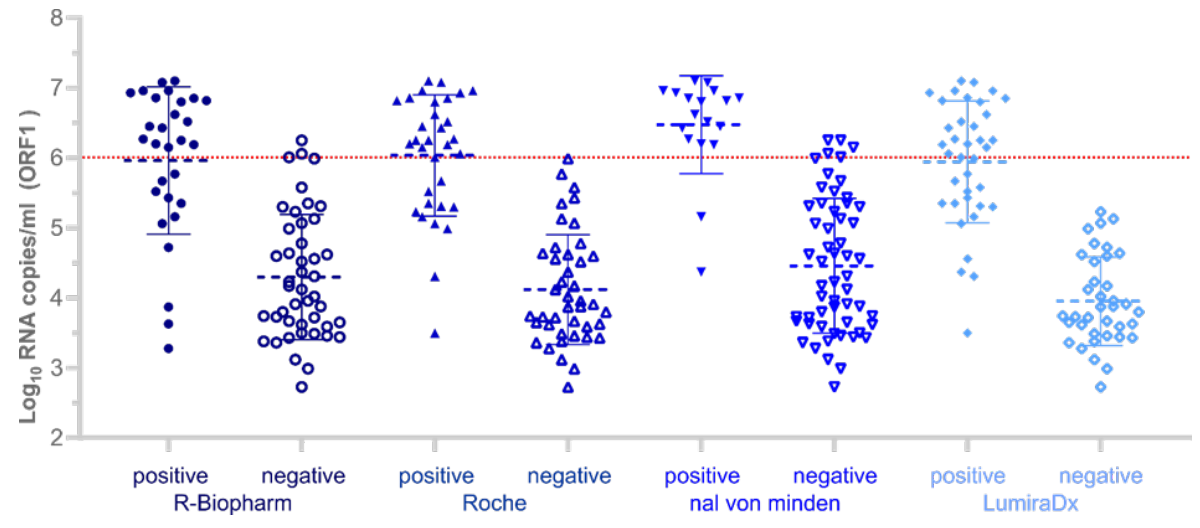
Figure 1. Antigen test analysis results for rRT-PCR-positive samples. Positive (filled data point symbols) and negative (empty data point symbols) Ag-RDT results and corresponding log 10 RNA copies/mL for the ORF1 gene including mean and standard deviation bars for each test ( n = 74). The dotted horizontal line in red indicates the literature-based hypothetical threshold for potential infectivity (6 log 10 RNA copies/mL). Table 2. Positive test probability (50% and 95%) for the examined Ag-RDTs. Positive Test with 50% Probability Positive Test with 95% Ag-RDT (Values in log 10 RNA/mL)